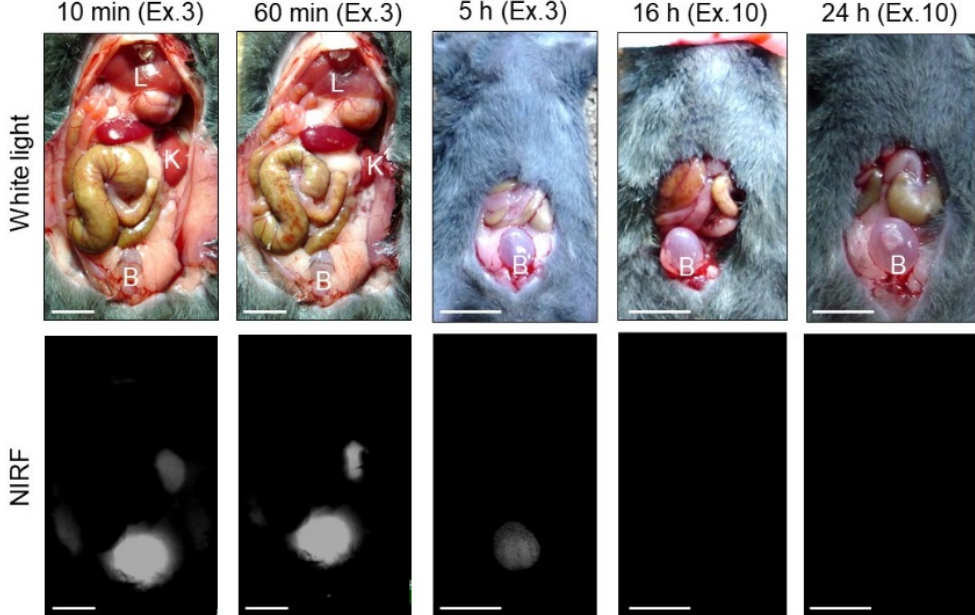
Figure 10. Representative near-infrared fluorescence (NIRF) imaging of normal bladders in three mice after intravenous administration of ASP5354 (240 nmol/kg body weight). Excitation levels (Ex.) are shown above photos. NIRF intensities in photos for 10 and 60 min are saturated because of too high intensity. NIRF is displayed in white. Scale bar represents 10 mm. B, bladder; K, kidney; L, liver.